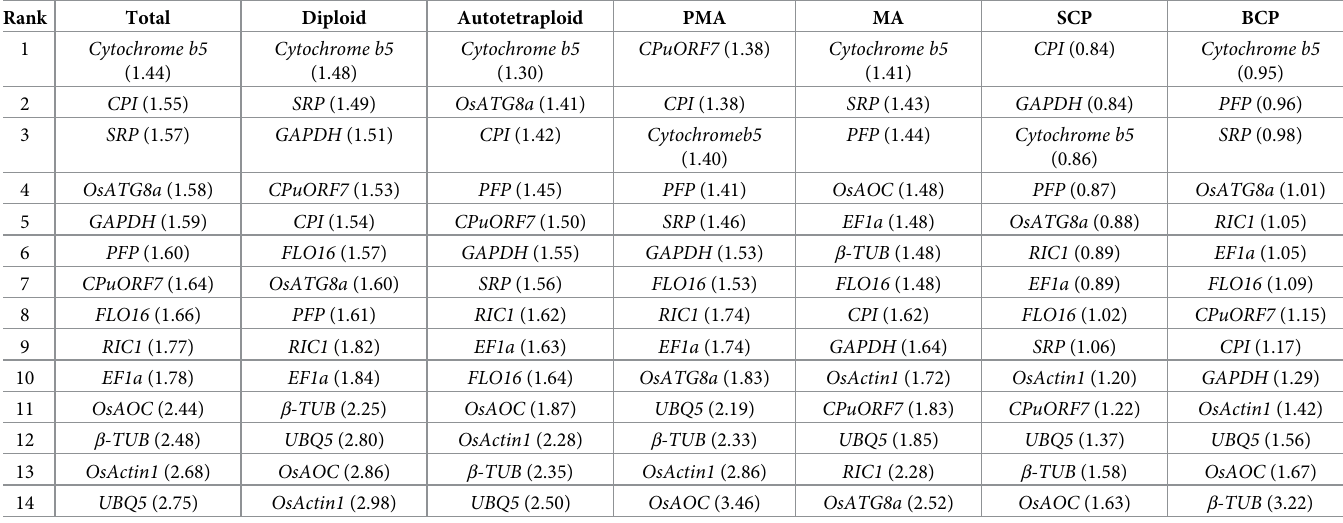
Table 2. Stability analysis of candidate reference genes assayed by Δ Ct